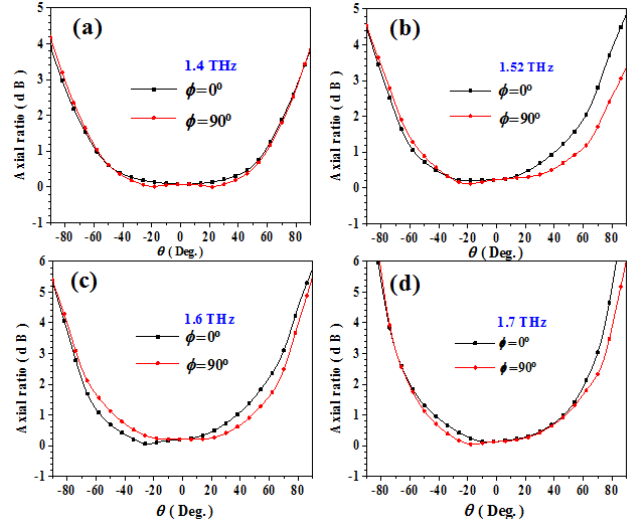
Figure 7. ( a ) Simulated axial ratio of the feeding horn antenna at 1.4 THz. ( b ) Simulated axial ratio of the feeding horn antenna at 1.52 THz. ( c ) Simulated axial ratio of the feeding horn antenna at 1.6 THz. ( d ) Simulated axial ratio of the feeding horn antenna at 1.7 THz. In all panels the axial ratios in φ = 0° plane and φ = 90° plane are demonstrated, respectively.